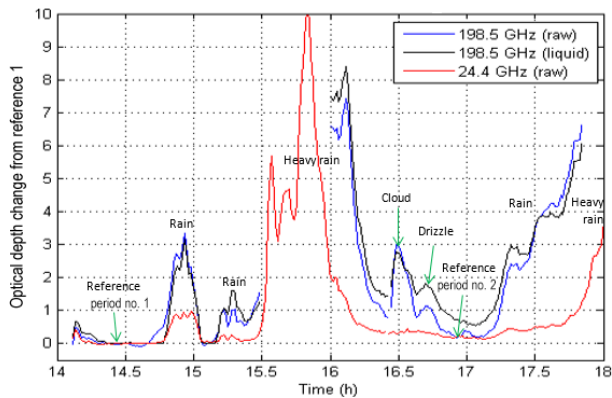
Figure 2. Blue and red lines show observed changes in optical depth at 198.5 and 24.4GHz relative to reference period 1. The black line shows changes in optical depth at 198.5GHz due to changes in liq- uid water after removing the contribution from changes in vapor pressure and